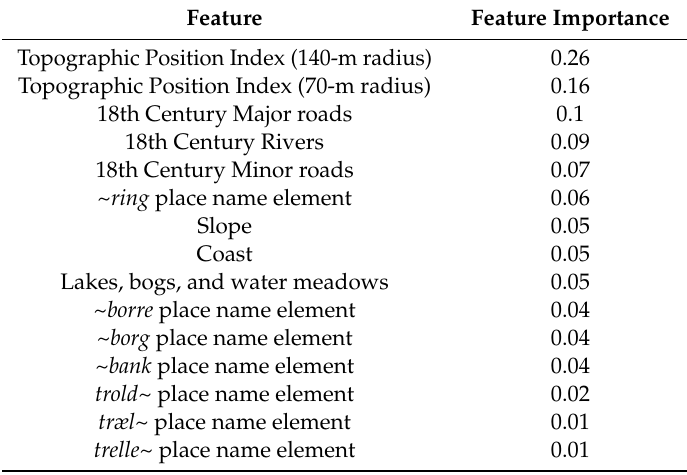
Table 5. The relative importance for map layers / features used to train the random forests